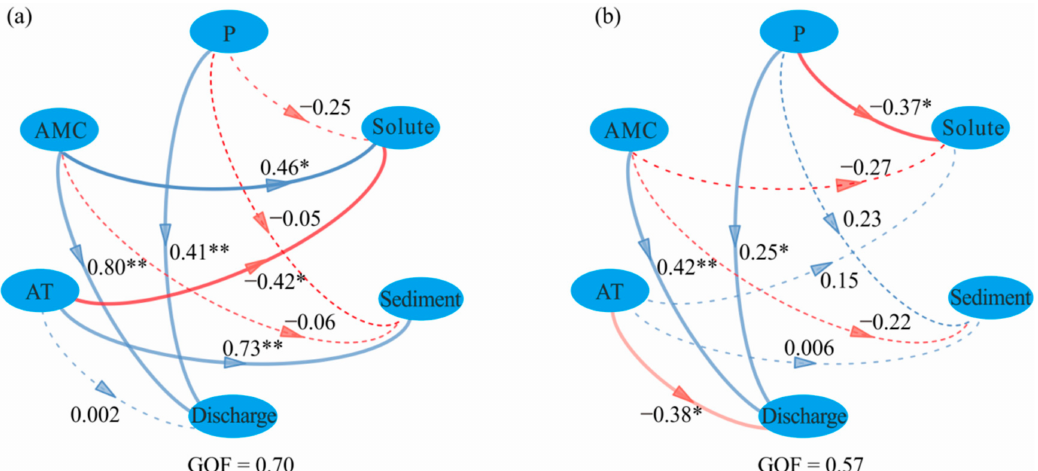
Figure 6. Results of partial least-squares path modeling for the periods ( a ) from 18 April to 5 May (the spring period) and ( b ) from 14 July to 23 August (the summer period). The numbers and asterisks adjacent to the arrows represent estimated values and the significance of the correlation, and the blue/red arrows represent positive/negative correlations. Significant ( p < 0.05) and highly significant ( p < 0.01) correlations are represented by asterisks (*) and double-asterisks (**), respectively, and the GOF represents the overall goodness of fit of the